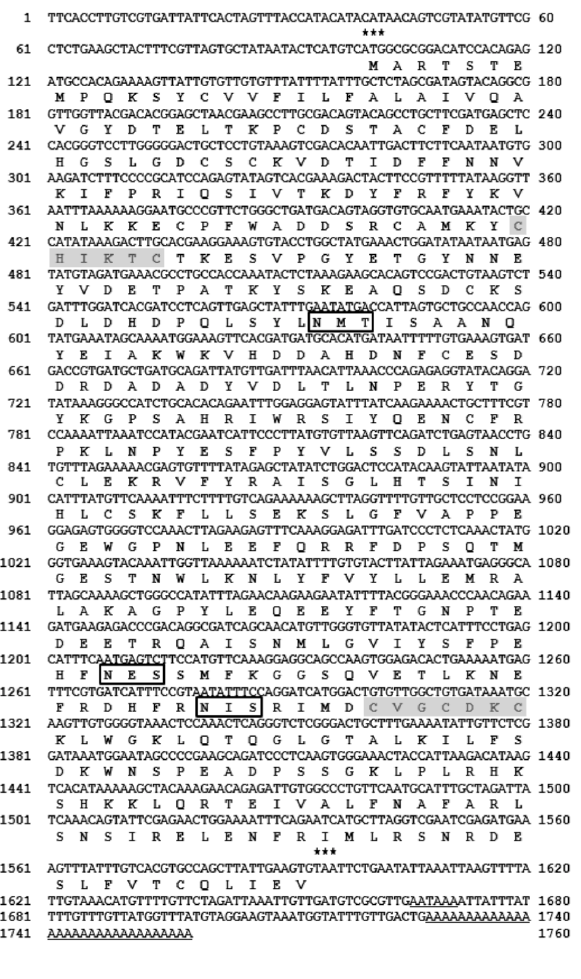
Figure 1. Nucleotide and deduced amino acid sequences of B. mori bERO1 cDNA. The predicated amino acid sequence is shown below the nucleotide within the open reading frame. Two activation domains, CHIKTC (111~116 a.a) and CVGCDKC (266~272 a.a), are indicated in the shadow box. The letters in the box indicate three putative glycosylation sites. The translation start and stop codons are indicated by asterisks. The underline nucleotide sequences indicate the putative polyadenylation signal and poly (A) tail, respectively.